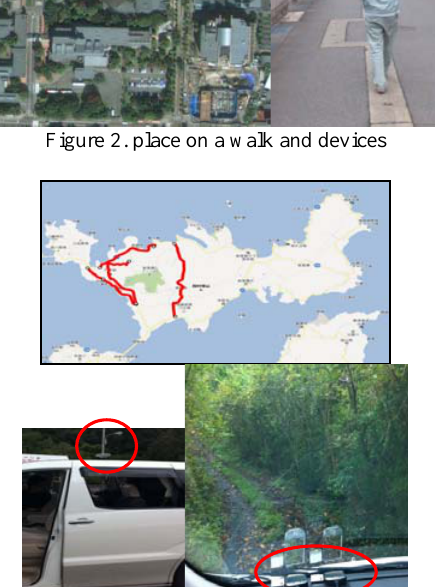
Figure 3. observation area and devices